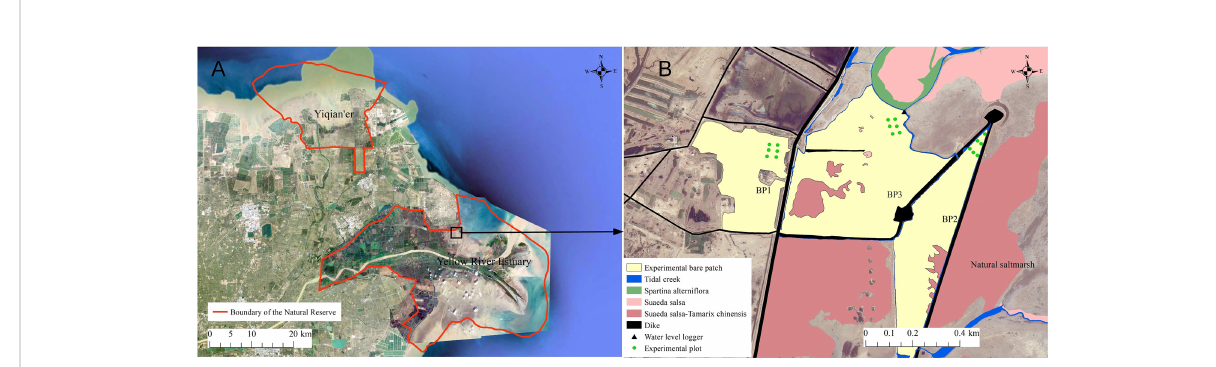
FIGURE 2 Location of the study area. (A) Boundaries of the nature reserve. (B) Three types bare patches investigated in this study. BP1, BP2, and BP3 are complete-enclosed bare patch, semi-enclosed bare patch, and open bare patch,